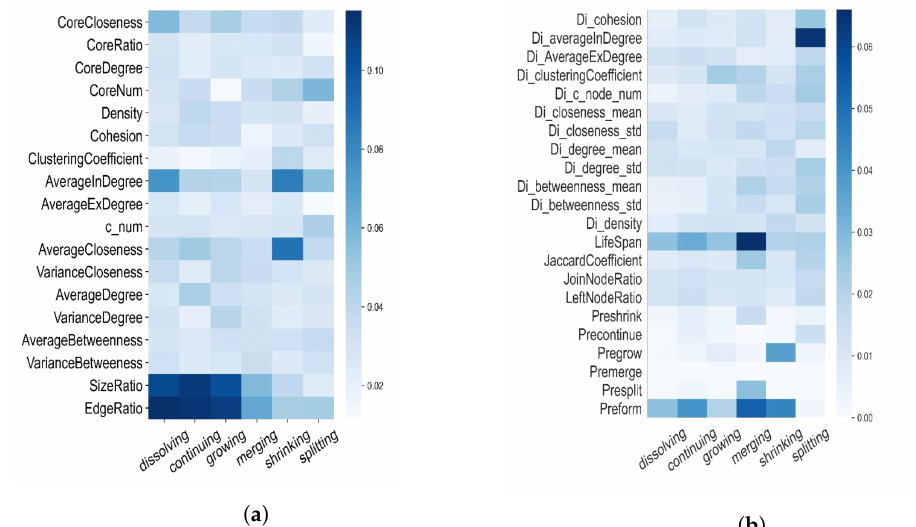
Figure 3. Distribution of the importance of each feature in the Enron data set: ( a ) Core node features and Community structural features; ( b ) Community sequential features and Community behavior